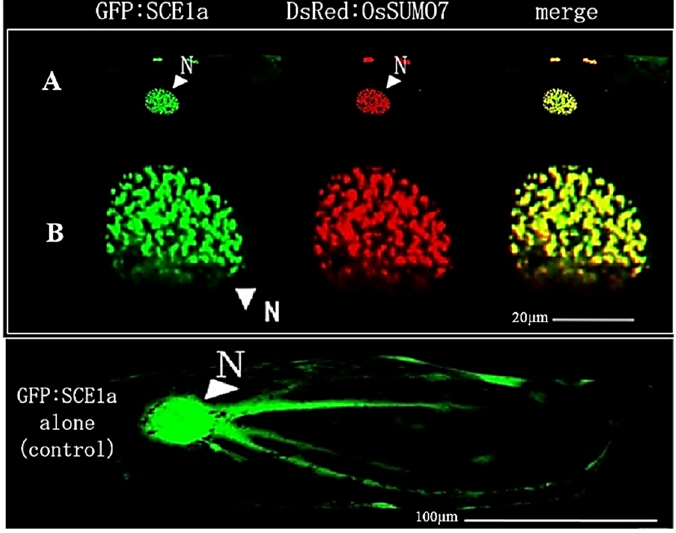
Figure 8. ( A ) Co-expression and co-localization of DsRed:OsSUMO7 with GFP:SCE1a in the nucleus of onion cells. ( B ) Co-expression and co-localization of DsRed:OsSUMO7 with GFP:SCE1a in the nucleus with high magnification.